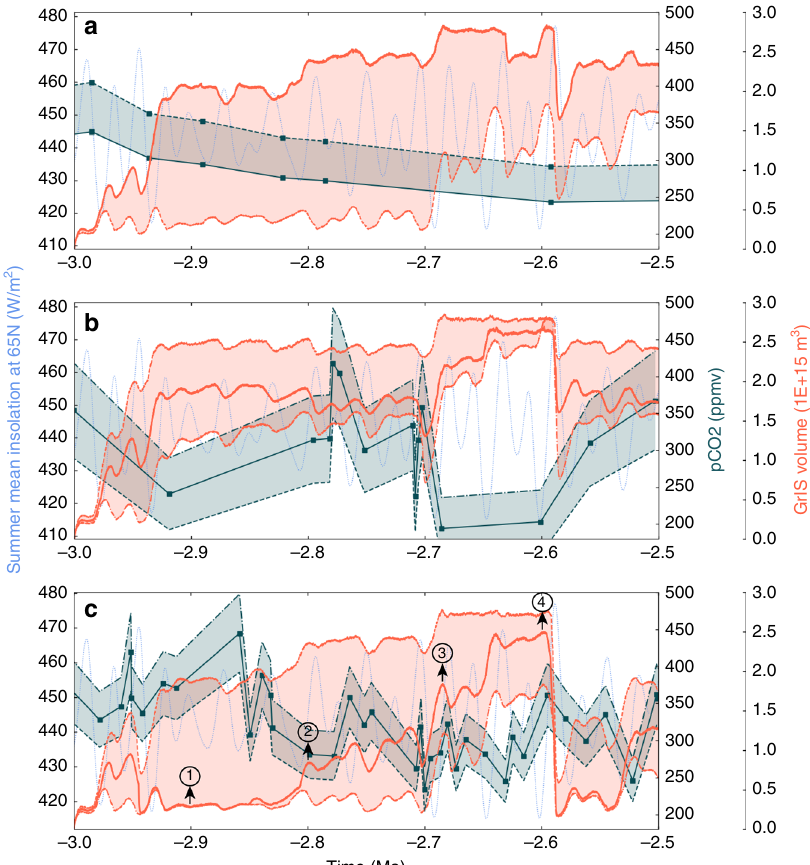
Fig. 2 Simulated GrIS volume evolution based on different pCO 2 records. a Seki et al. 34 ; b Bartoli et al. 32 ; c Martinez et al. 33 . Dashed light blue line represents the boreal summer insolation at 65°N. Orange lines are the simulated GrIS volumes based on pCO 2 records and their uncertainties, represented by the solid teal lines and shaded teal areas. a Alkenone-based pCO 2 record of Seki et al. 34 , determined using size-corrected ε 37:2 values for the modern range of b -values 34 . The solid (dashed) orange line is the simulated GrIS volume obtained with the solid (dashed) pCO 2 line. b Boron isotopes-based pCO 2 record of Bartoli et al. 32 , with a 2 σ error range. The solid orange line is the simulated GrIS volume with mean pCO 2 values and shaded orange lines are the GrIS volumes obtained with low and high extremes of the pCO 2 uncertainties. c As in b but for the boron isotopes-based pCO 2 record of Martinez-Boti et al. 33 , with an uncertainty range corresponding to 68% of 10,000 Monte Carlo simulations with full propagation of uncertainties 33 . Circled numbers at 2.9 Ma, ~2.8 Ma, ~2.72Ma and 2.6 Ma correspond to the ice sheet snapshot displayed in Fig.